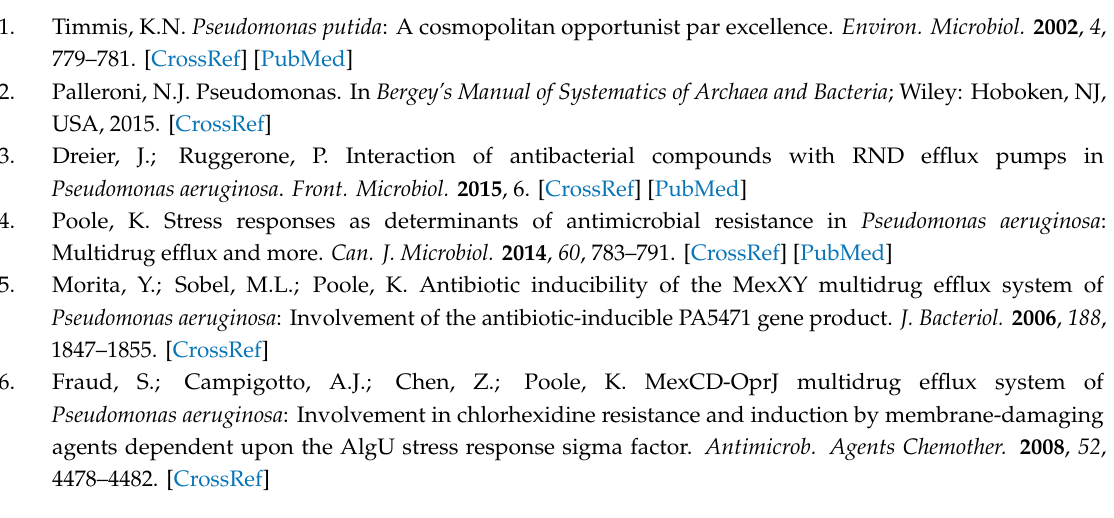
Figure S1: Mutations in Revertant A, B and C strains, Figure S2: Phenotype complementation with ttgB and mexF in the Revertant A ∆ mexF and ∆ ttgB ∆ pp_2827 ∆ mexF strains, Figure S3: Susceptibility of Revertant B to chloramphenicol, Table S1: List of primers used in this